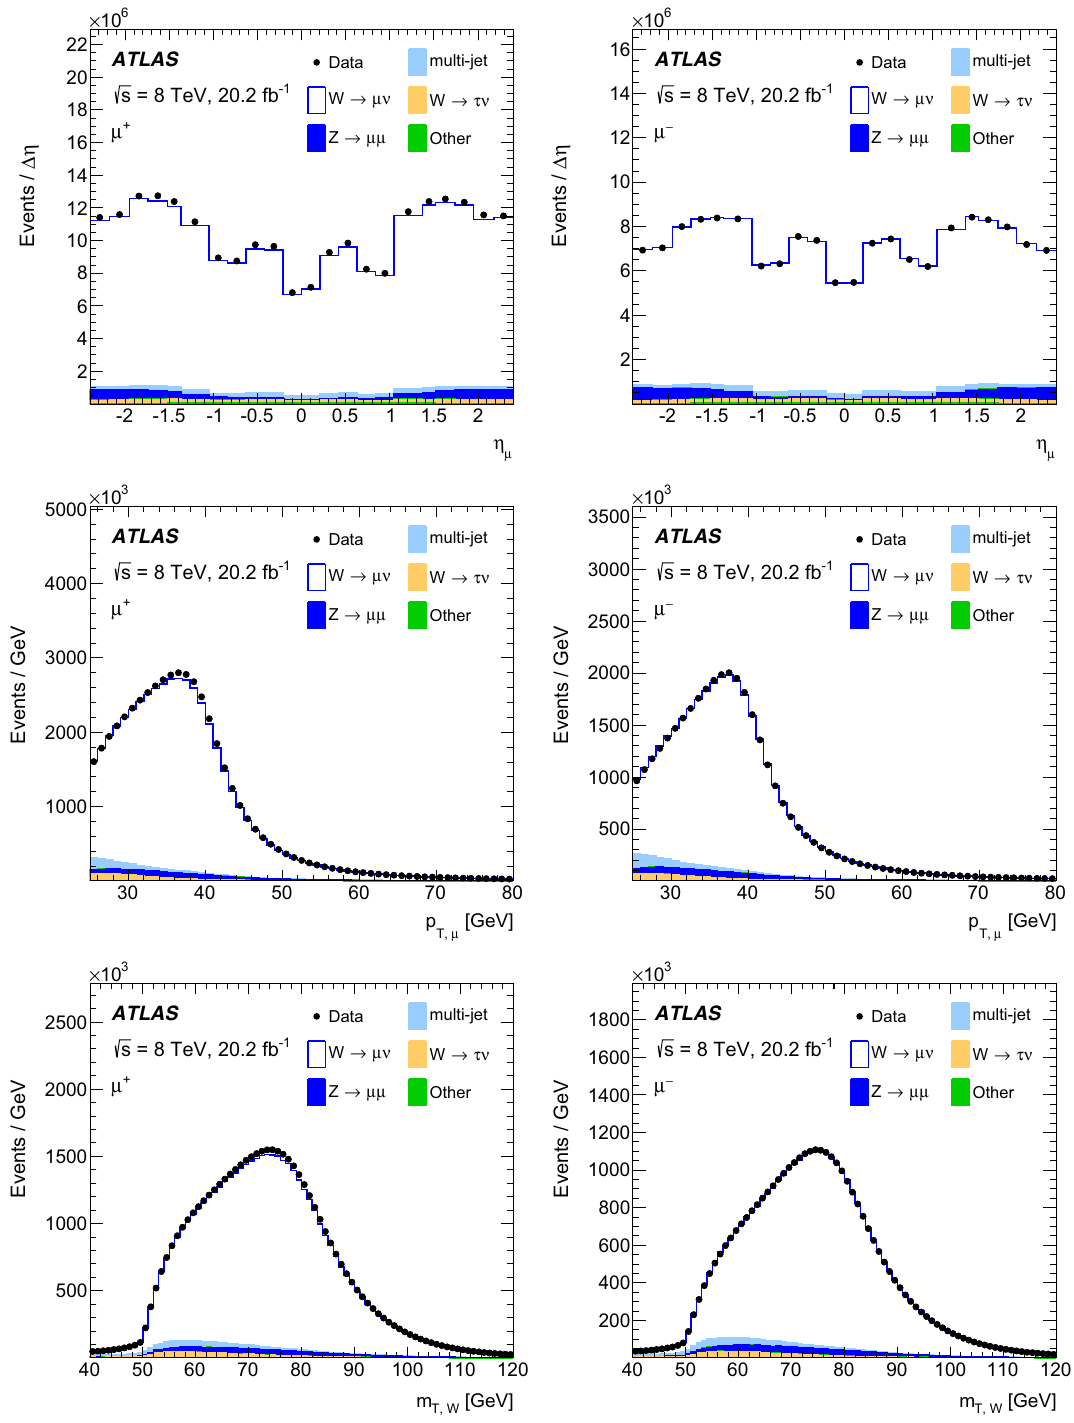
Fig. 1 The muon η (top), muon p T (centre), and W boson transverse mass (bottom) distributions of selected events with positive muons (left) and negative muons (right). The statistical uncertainties of the data points are smaller than the size of the markers where N data , i is the number of selected candidate events in data, N bkg , i is the number of background events estimated using the methods described in Sect. 3.4, (cid:7)η i is the width